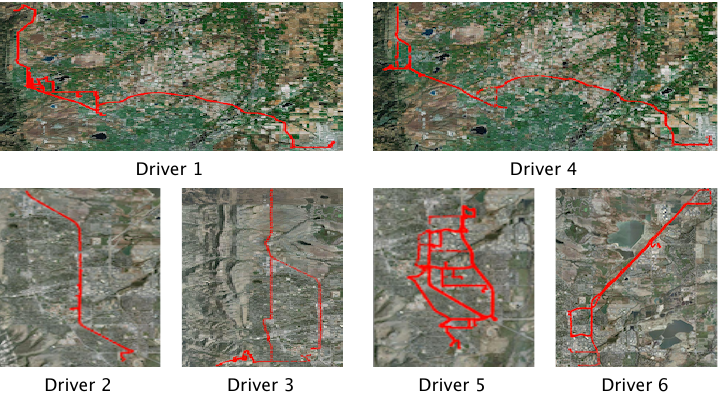
Figure 7. Heterogeneous routes driven by the six users in our study.